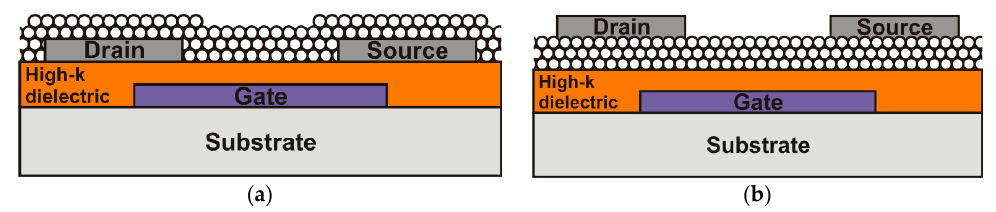
Figure 1. Schematic cross section of ZnO TFTs applying ( a ) inverted coplanar and ( b ) inverted staggered setups.